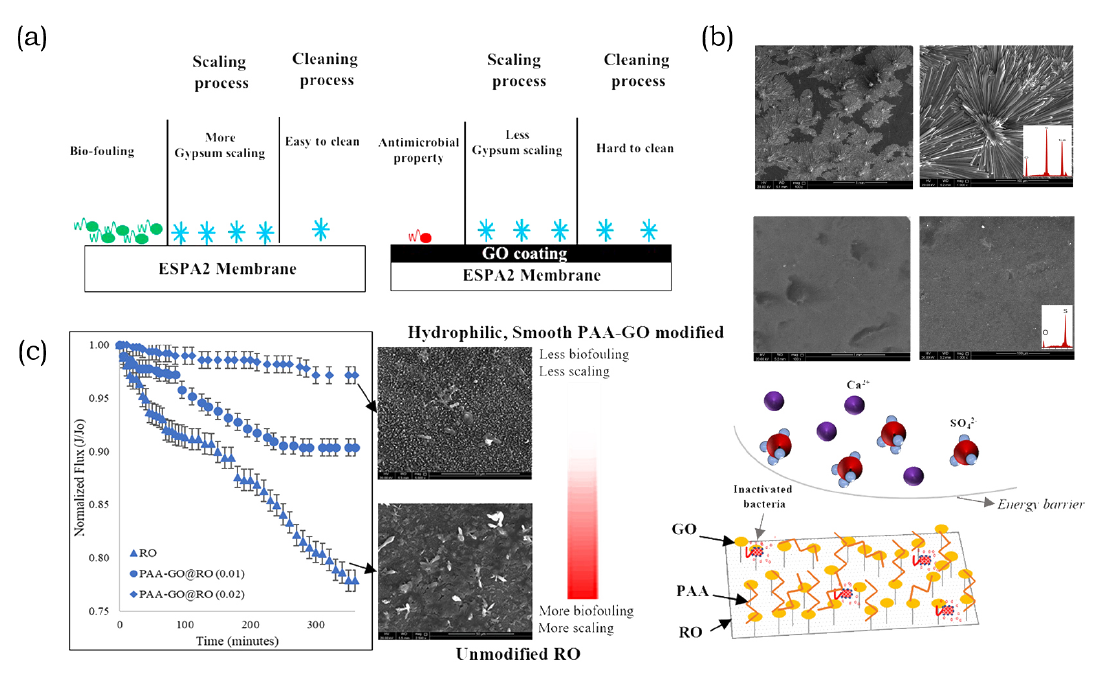
Figure 12. ( a ) I mproved biofouling and scaling propensity, but reduced flux recovery of GO@PA membranes. Reprinted from [233], Copyright (2018) with permission from Elsevier. ( b , c ) Scale layer on the PA RO membrane and the characteristic needle-like crystals shown in the top two pictures. The bottom pictures demonstrate the successful antiscaling PAA-GO functionalized membrane: normalized flux, membrane surface, and illustrated membrane surface modification. Adapted from [234], Copyright (2020) with permission from Elsevier. License